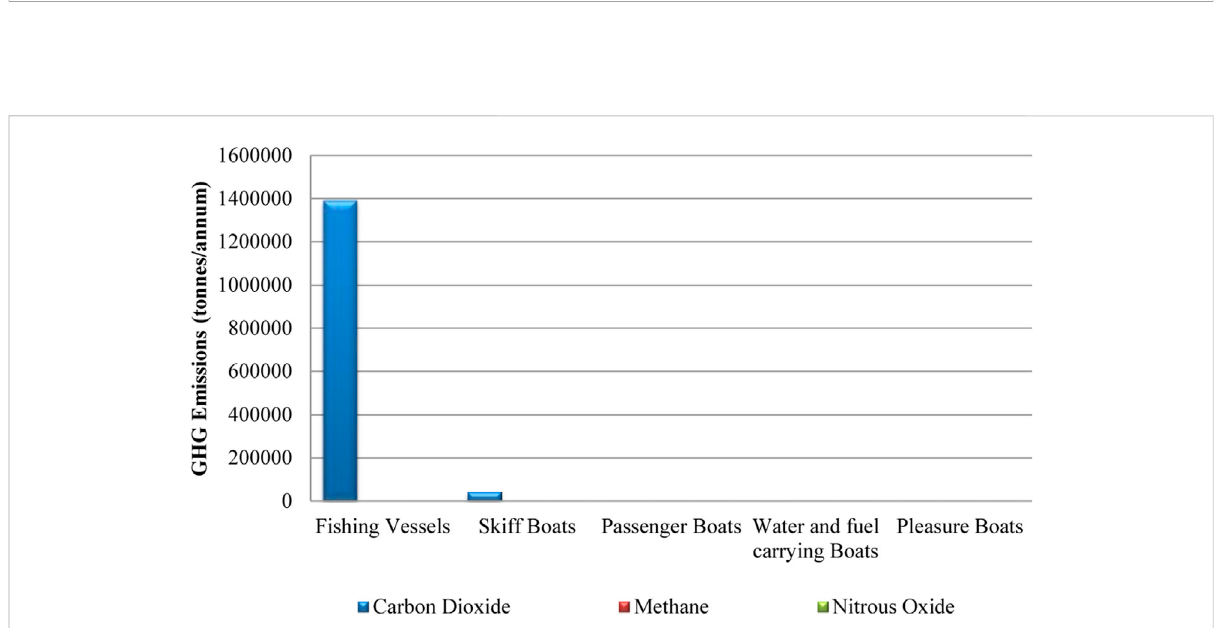
FIGURE 12 Breakdown of GHG emissions load from fi shing vessels and other crafts in sindh, Pakistan.